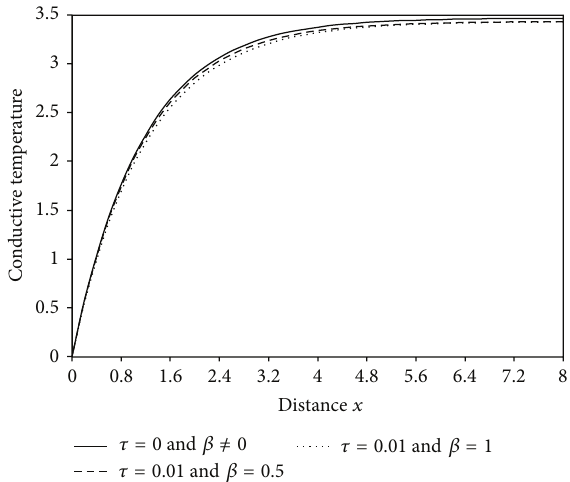
Figure 6: Dependence of stress distribution on velocity V of heat